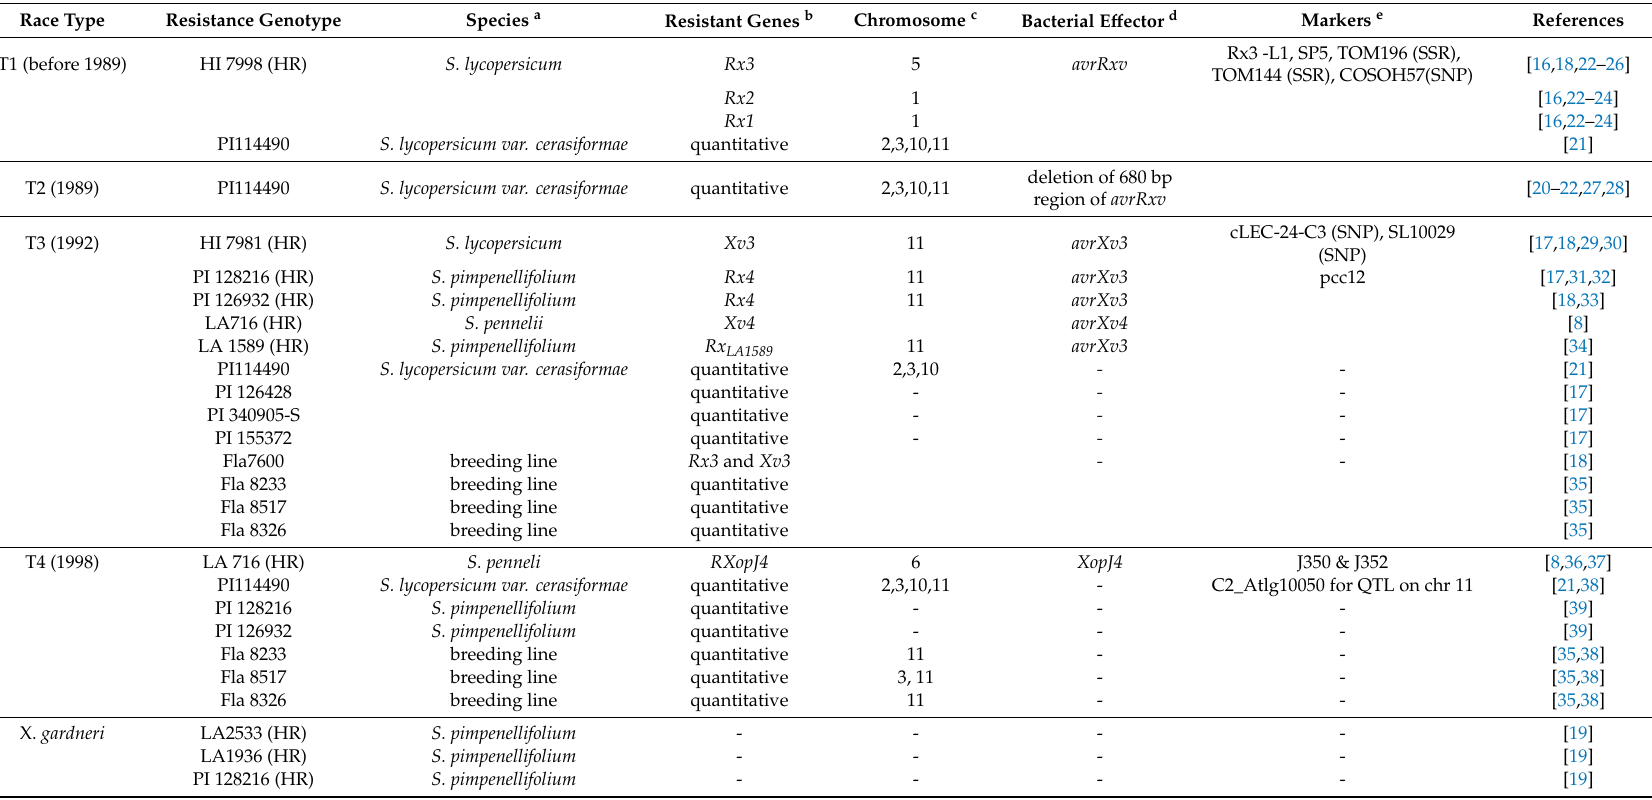
Table 1. Summary of breeding e ff orts for resistance to di ff erent races of Xanthomonas, causing bacterial spot disease in